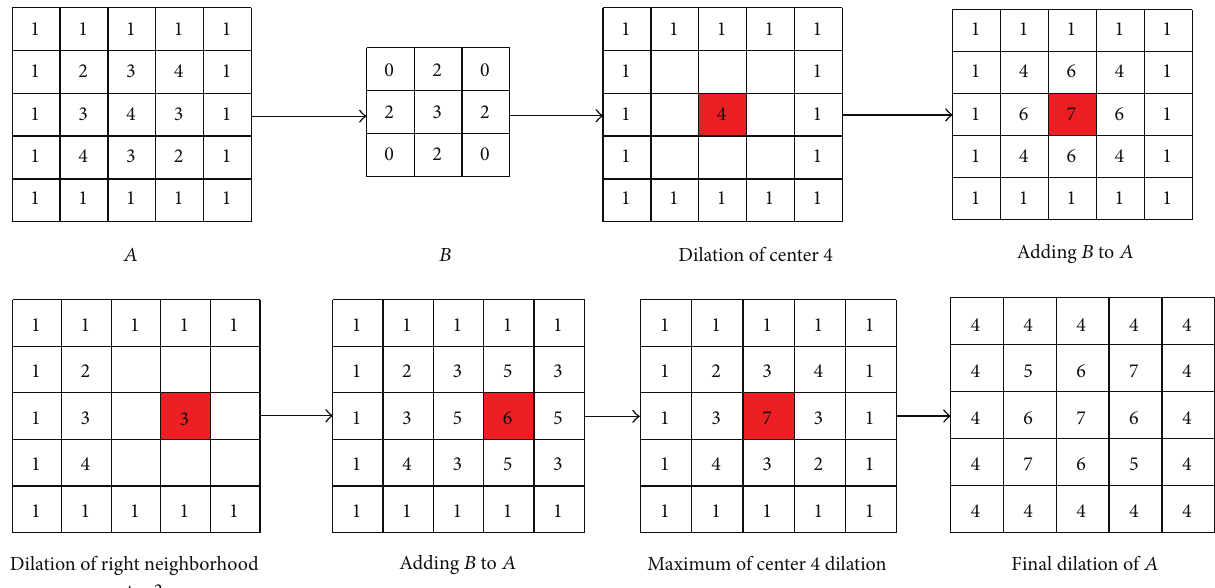
Figure 5: Example of a dilation (the red box represents the dilation of center 𝐴